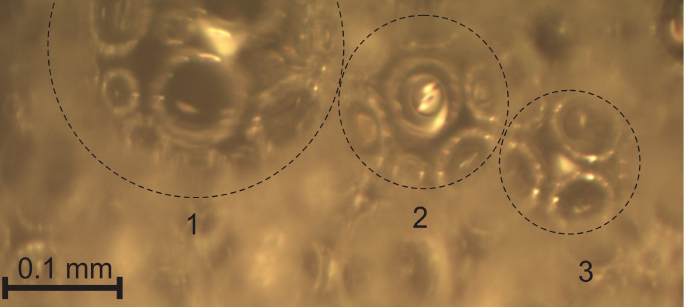
Figure 13. Front view of the walls (visible through the large cut bubbles 1, 2, and 3 between a large bubble and a number of smaller